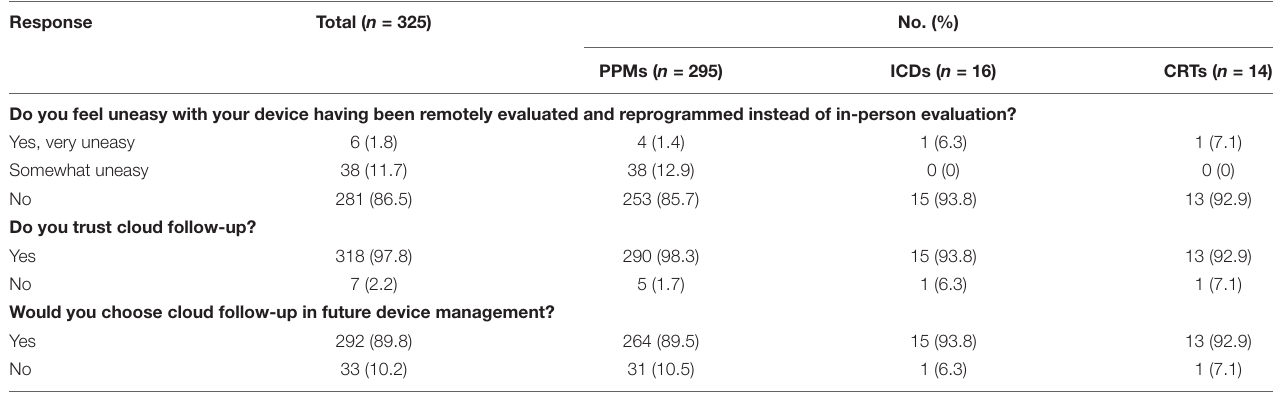
TABLE 5 | Patient questionnaire results.